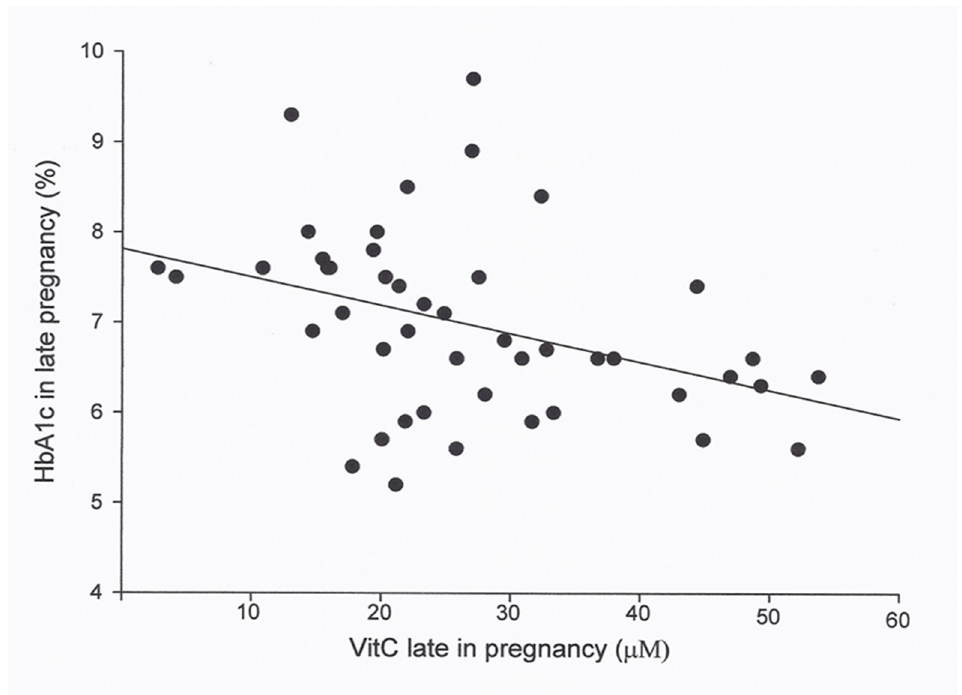
Figure 1. Plasma vitamin C (vitC) in 46 women with type 1 diabetes in late pregnancy in relation to the HbA1c in late pregnancy. Regression analysis showed that the means of HbA1c in late pregnancy was associated with vitC in late pregnancy ( r ² = 0.15, p = 0.008, n = 46), and the association persisted when adjusted for creatinine clearance third trimester ( r ² = 0.31, p = 0.029, power of test >80%).